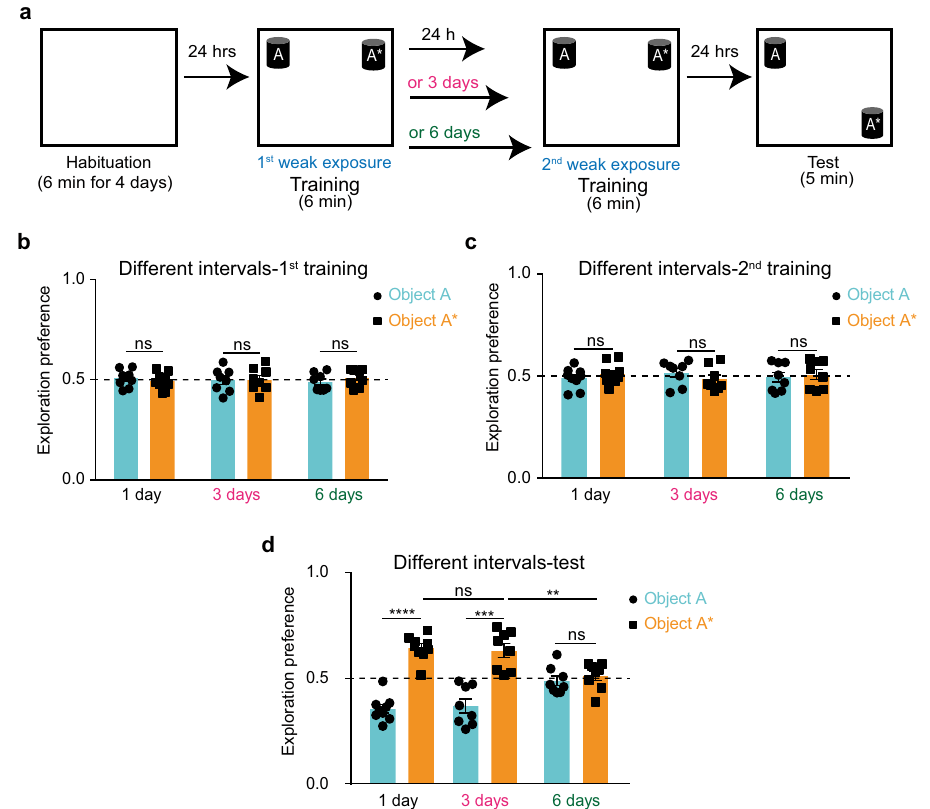
Fig. 3 Re-exposure facilitates STM consolidation. a NOL two-training paradigm with different intervals in between. Exploration preference for each object during the fi rst training ( b ), the second training ( c ), and the test ( d ) sessions for different intervals groups; 1-day ( n = 9), 3-day ( n = 8), and 6-day ( n = 8). Comparisons were made using two-way analysis of variance (ANOVA) followed by Bonferroni Post hoc test; ns not signi fi cant ( P > 0.05), ** P < 0.01, *** P < 0.001, **** P < 0.0001. Data are presented as the mean ±